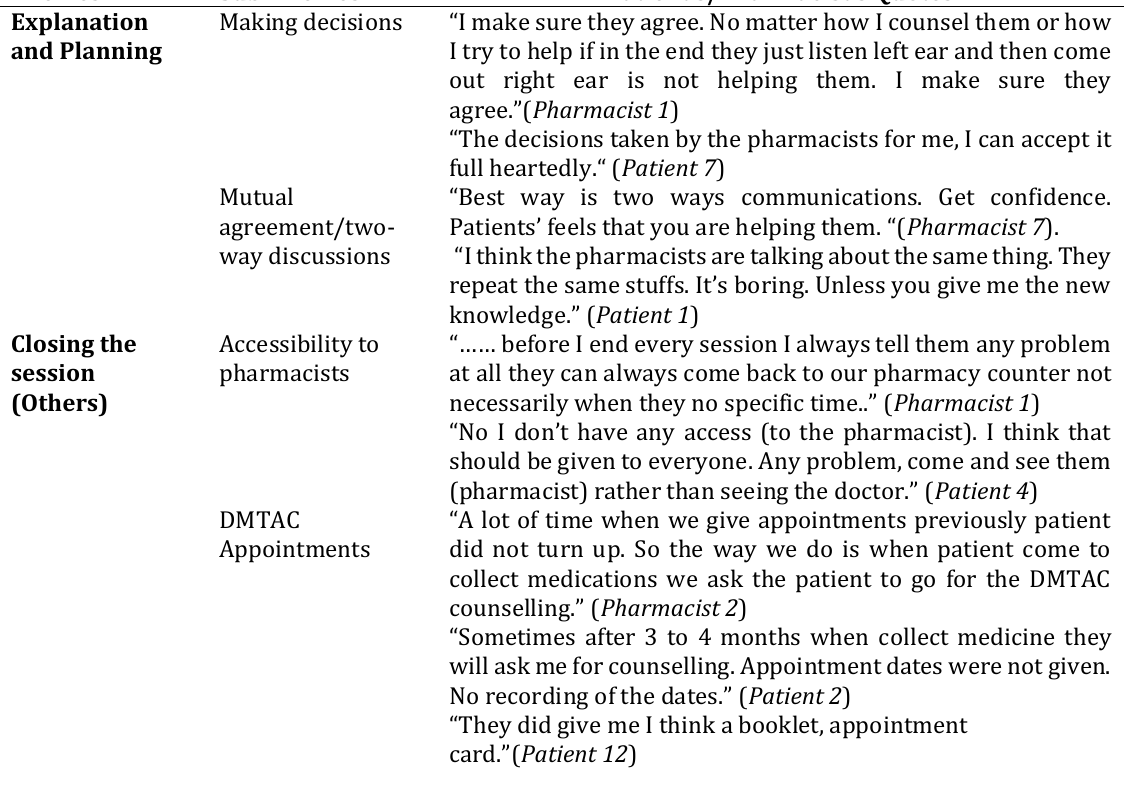
Table 2b. Themes, Sub-themes and Patient’s/Pharmacist’s Quotes